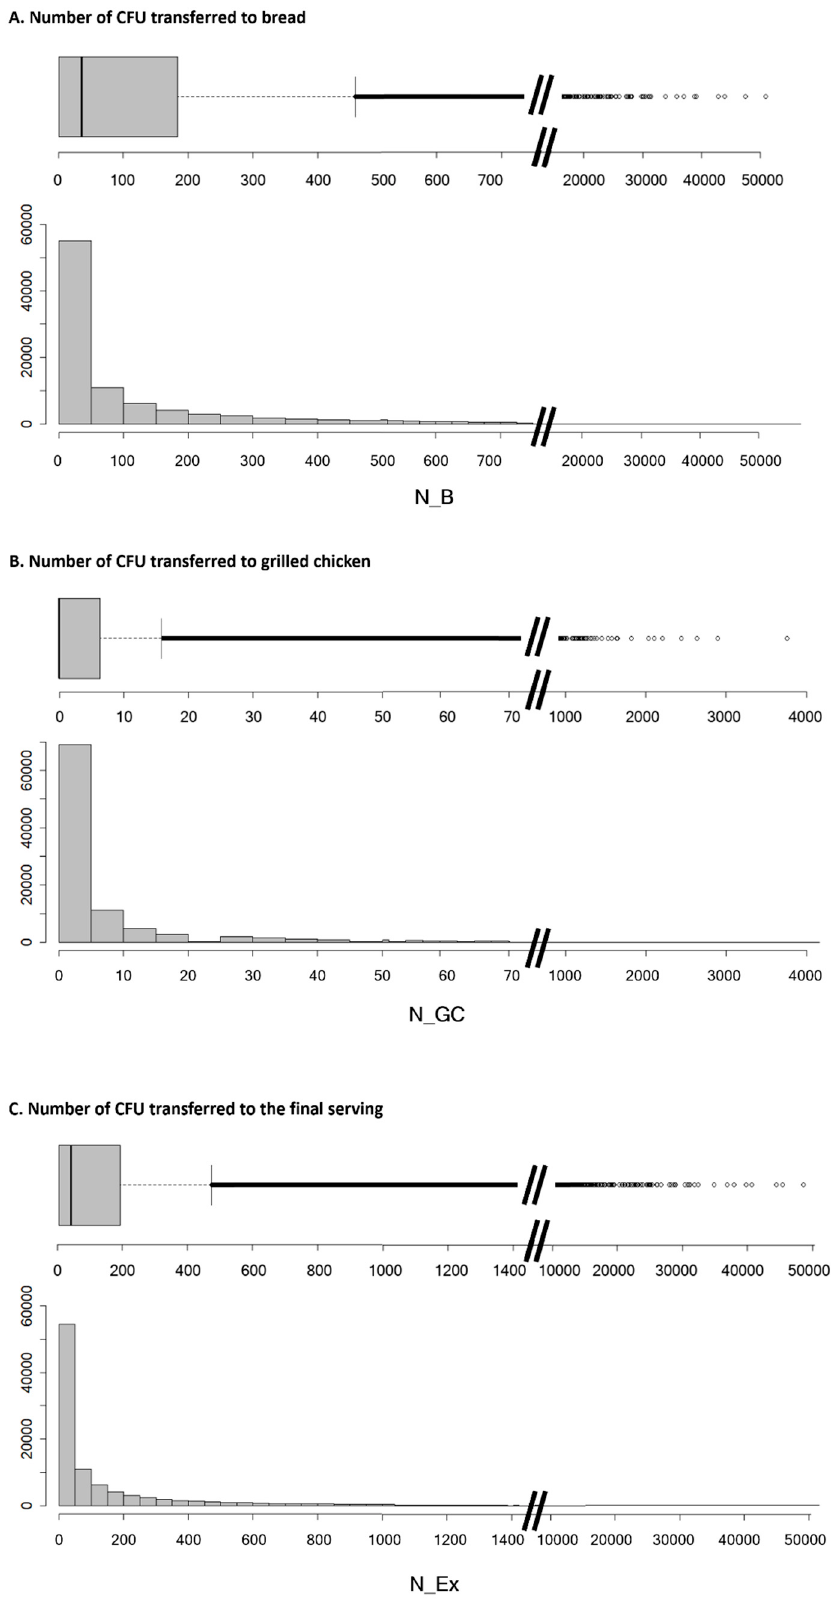
Figure 3. Estimated relative frequencies on the number of ESBL-/AmpC-producing E. coli transferred from raw chicken meat to ( A ) bread (N_B), ( B ) grilled chicken (N_GC) and ( C ) the final serving (N_Ex) due to the cross-contamination and recontamination events contemplated in the